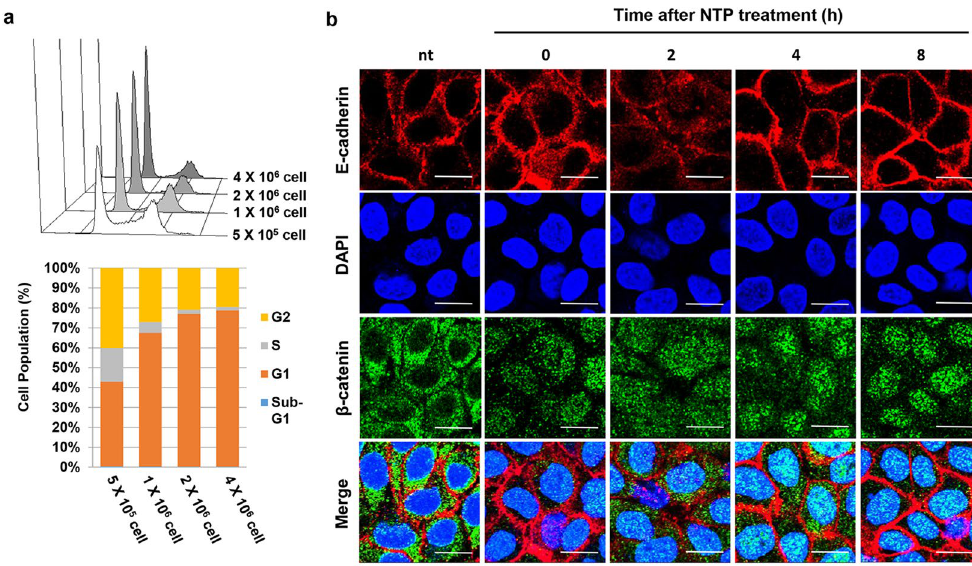
Figure 2. The effect of NTP on β -catenin localization in confluent HaCaT cells. ( a ) The results of FACS analysis using PI. HaCaT cells were seeded on 35 mm dish at the indicated concentration. Data shown are representative of four independent experiments. ( b ) The result of confocal imaging of immunofluorescence (Scale bar: 20 μ m). Cells were treated with NTP for 5 minutes at 0, 2, 4, and 8 hours before harvesting. After fixation, cells were stained for E-cadherin (red) and β -catenin (green). DAPI was used for counter staining of the nuclei. nt: non- treated.